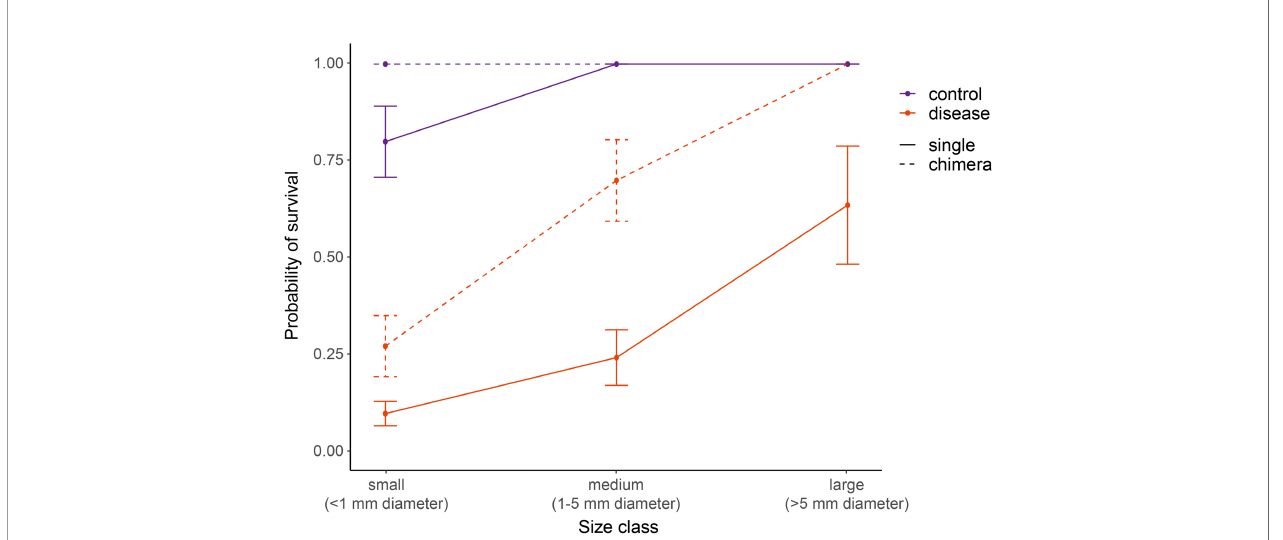
FIGURE 8 | Relative SCTLD susceptibility of four-month-old C. natans varies by interactions of recruit size and grouping (single vs. chimera). Dashed lines indicate chimeric entities, here treated as a collective unit rather than individual recruits grouped together. “ Size class ” in chimeric entities refers to the total size of the collective unit, with the area of all constituent recruits added together. Recruits in the control treatment were not exposed to SCTLD, and thus represent the “ background mortality ” level expected for these juvenile corals. A GLM with correction for binomial survivorship data was used to fi t the data. Error bars indicate standard